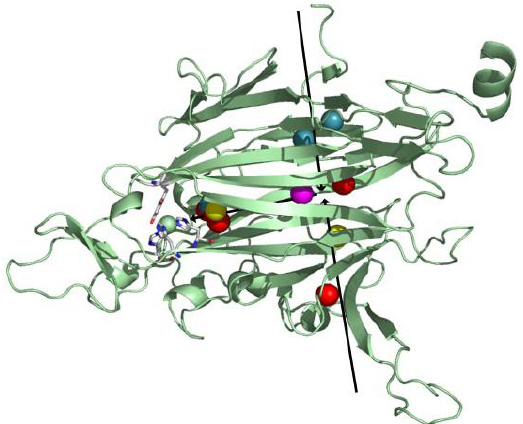
Figure 12. Overlay of xenon binding sites in xenon/CAO complexes. Domain D4 from one HPAO-1 monomer is drawn as a green cartoon, and active site residues are depicted in stick and colored by atom type (carbon, white). Xenon atoms are drawn as spheres and colored by enzyme source (PSAO, red; PPLO, yellow; AGAO, blue; HPAO-1, magenta). Arrows indicate the direction of O movement toward the active site. Figure from 2